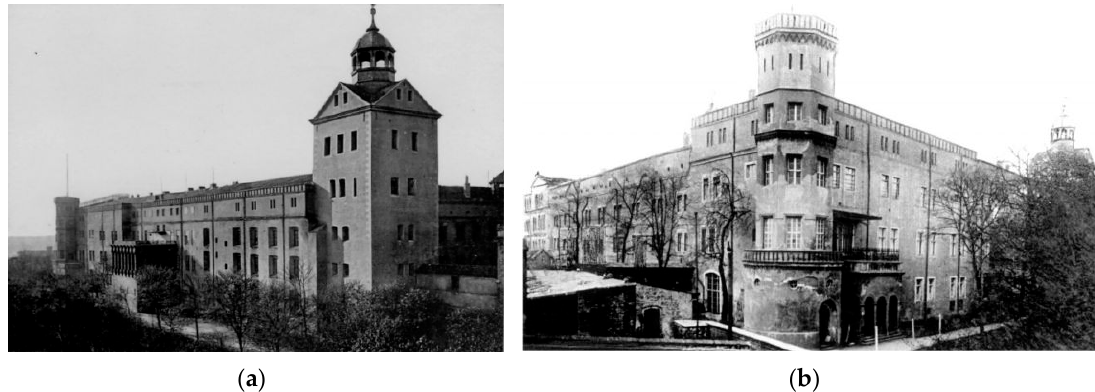
Figure 4. ( a ) Northern wing after expansion, source: sedina.pl; ( b ) Neo-Gothic tower on the northeast corner, source: sedina.pl.